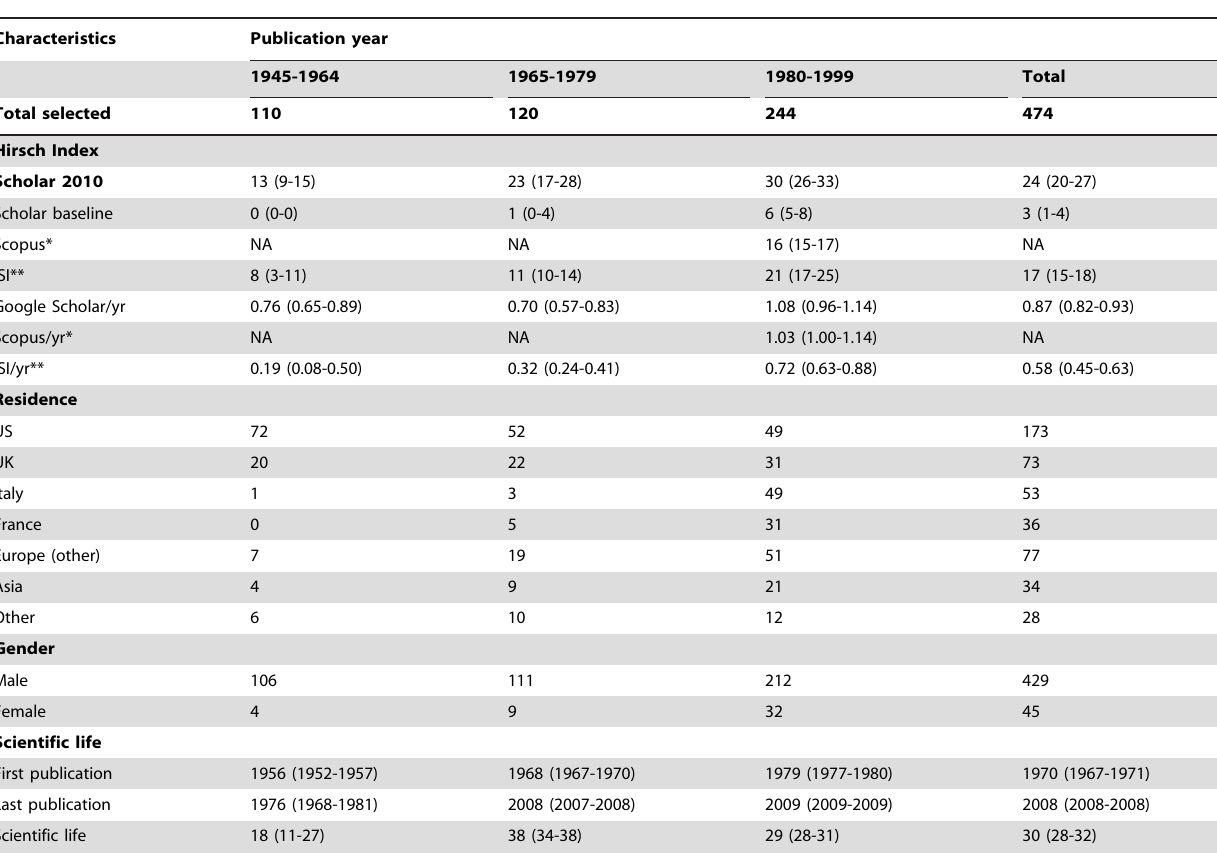
Table 1. Hirsch index and characteristics of included first